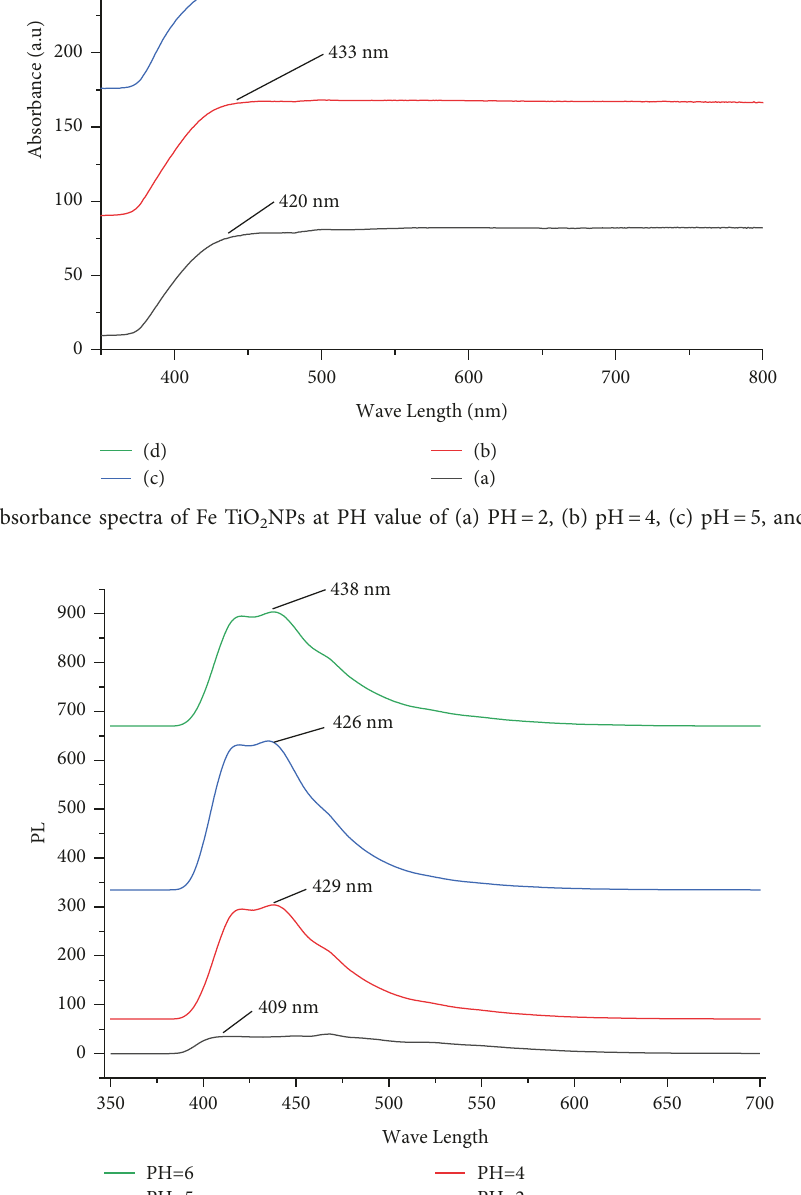
2 Nanoparticles at pH values of 2, 4, 5, and 6. Energy-dispersive X-ray spectroscopy